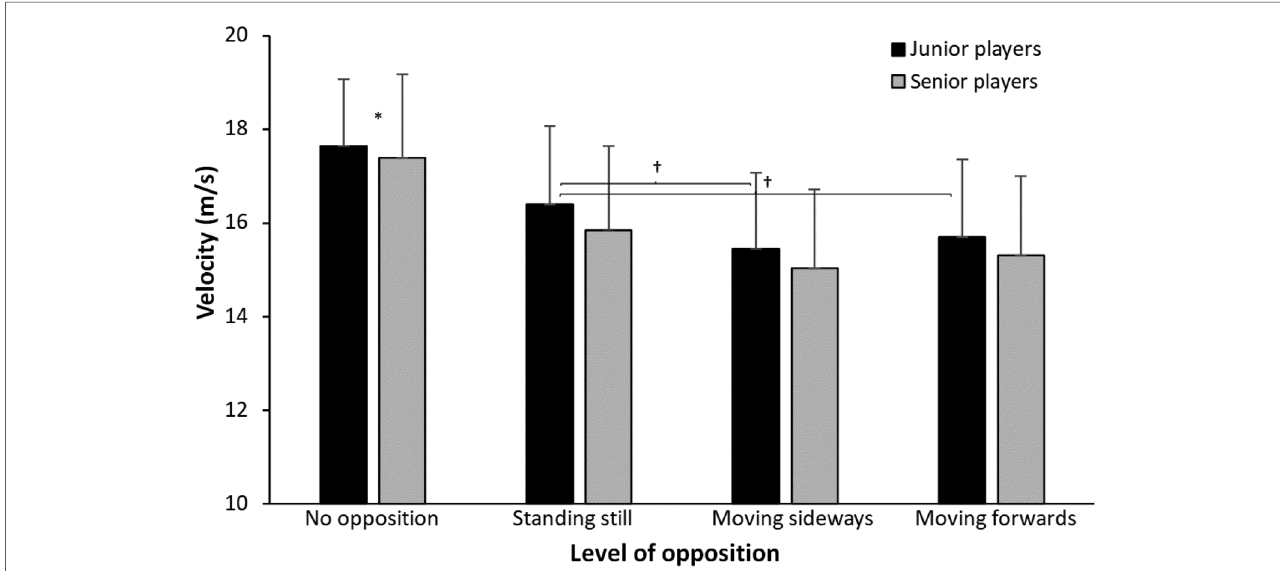
FIGURE 2 Mean (±SD) ball velocity over 10 attempts per group and level of opposition. * indicates a signi fi cant difference with all other levels of opposition for both groups on a p <0.05 level. † indicates a signi fi cant difference in ball velocity between these two levels of opposition for this group on a p <0.05 level.